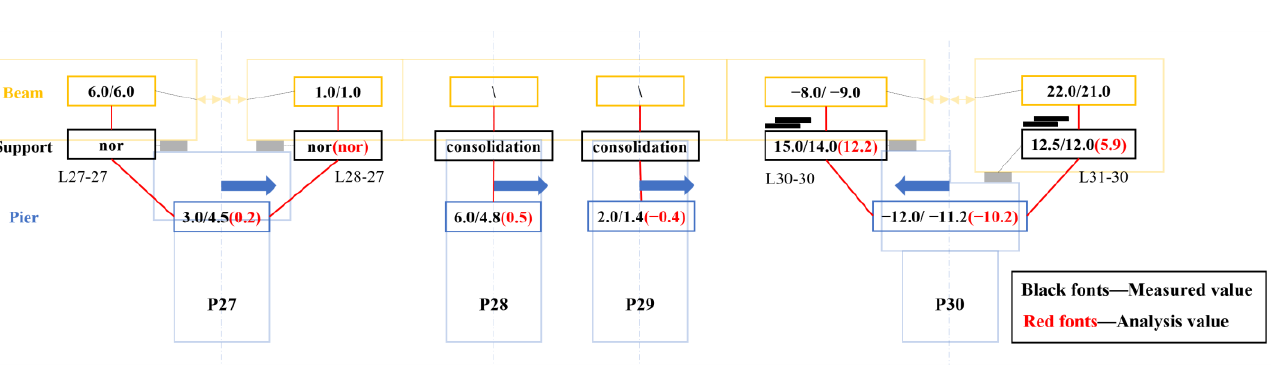
Figure 23. Numerical results and field investigation data between Piers P27 and P30 (cm).